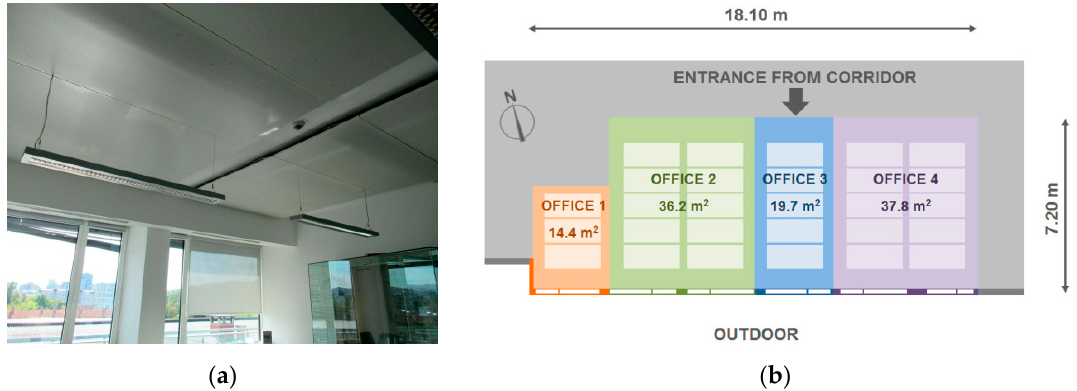
Figure 1. ( a ) Office 2 of premises which were the basis for modeling; ( b ) schematic floor plan of the offices with the radiation ceiling panels indicated by the brighter rectangles.